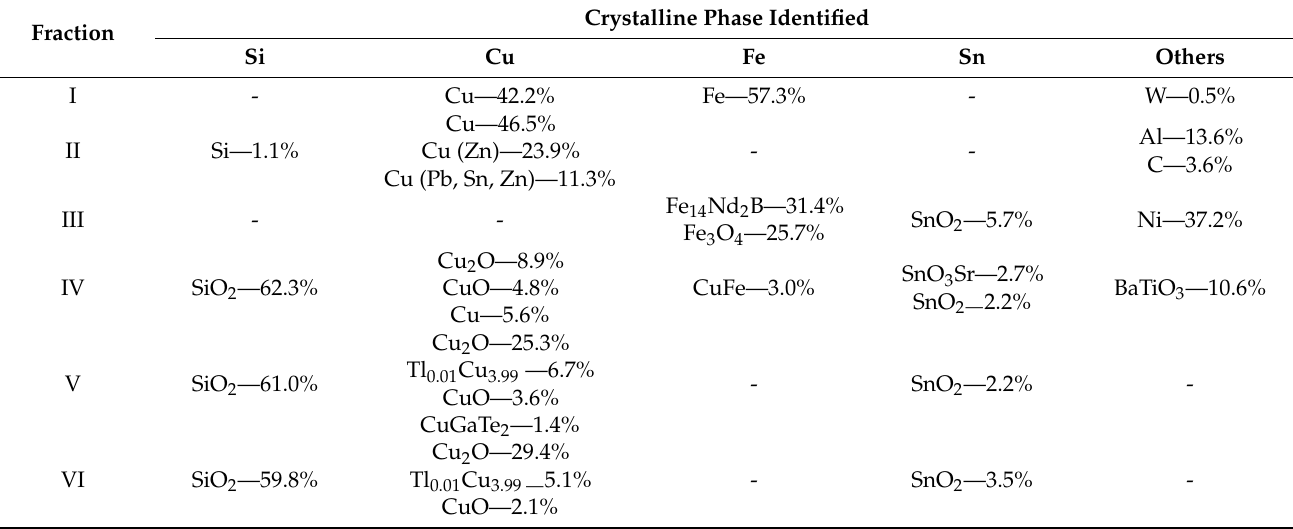
Table 12. Crystalline phases in particular fractions determined by X-ray